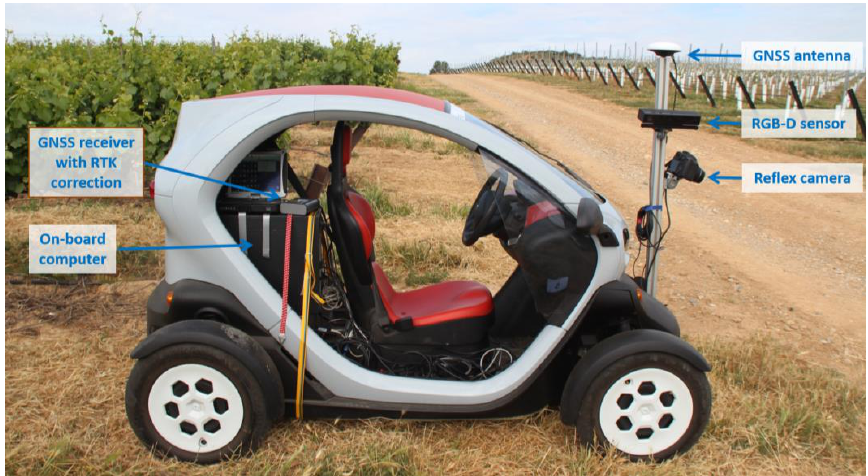
Figure 1. Field platform and on-board equipment.